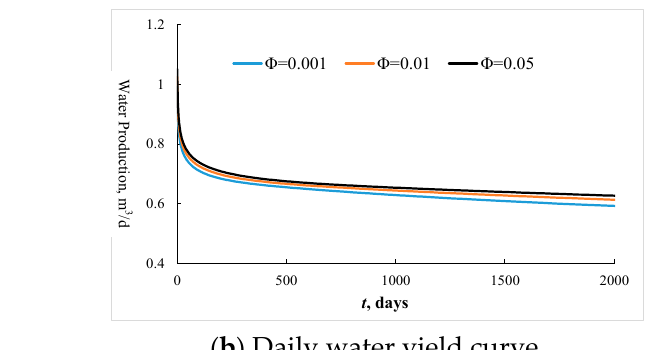
13 of 17 Figure 4. Comparison of production performance from the semi-analytical method and numerical simulation method. 4.2. Analysis of Factors Affecting Production Dynamics Based on the semi-analytical model, this paper focuses on the influence of the stress sensitivity coefficient, fracture porosity, and outer boundary distance on the productivi- ty of carbonate gas wells. The basic input parameters of the model are collected in Table 2. Table 2. Range of values for sensitive parameters. Parameter